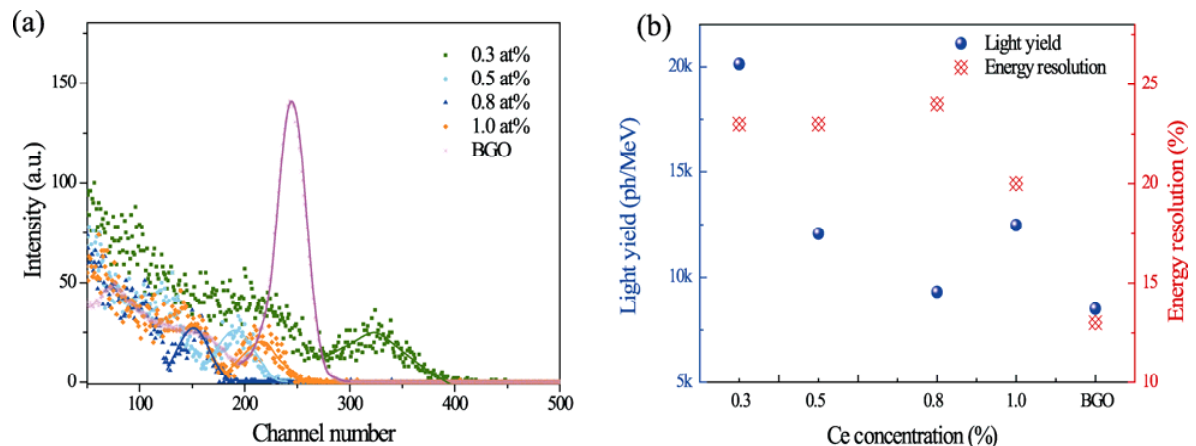
Fig. 8 (a) Pulse height spectra; (b) light yields and energy resolution of commercial BGO single crystal and LuAG–Al 2 O 3 nanoceramics (72 mol% Al 2 O 3 ) doped with different Ce concentrations (1100 ℃ , 2